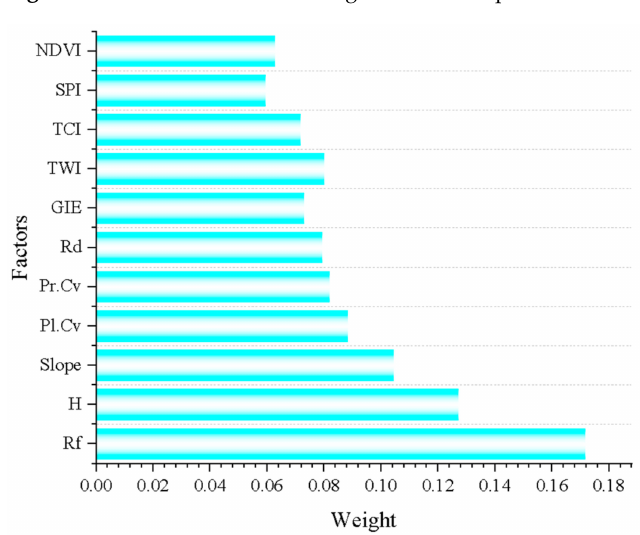
Figure 7. Weights of each impact